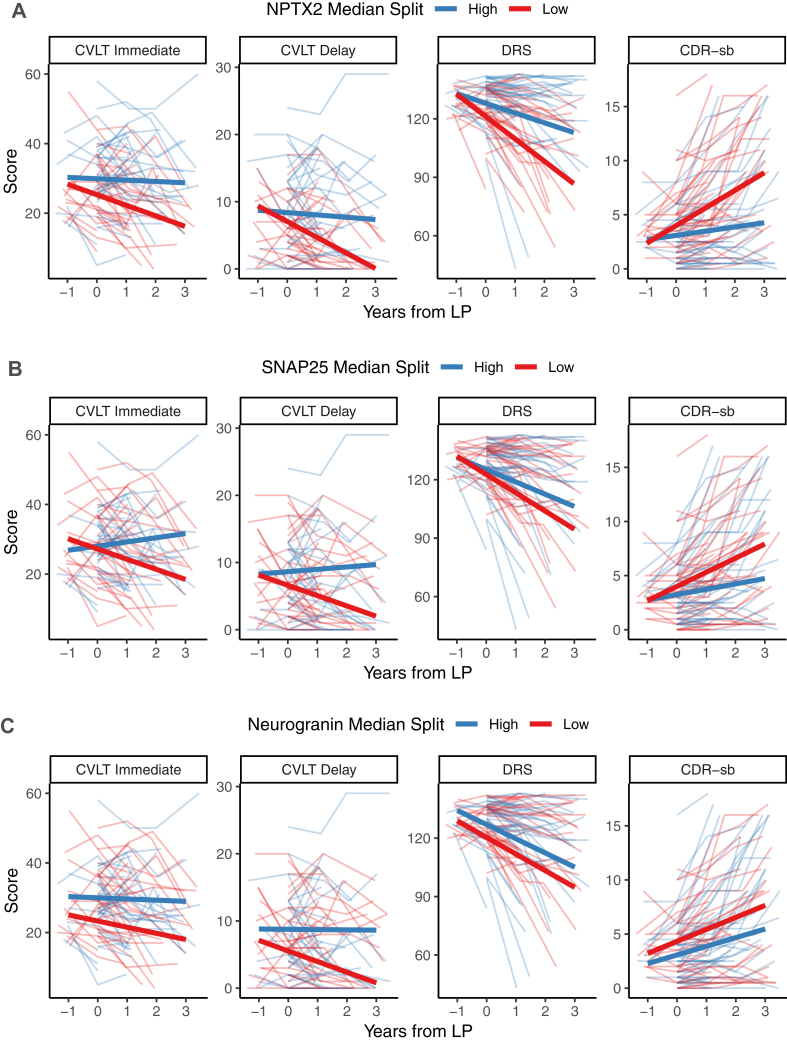
Biomarker prediction of longitudinal progression. Progression on the CVLT (immediate and delay), MDRS, and CDR Sum of Boxes (CDR-sb) divided via a median split of each CSF biomarker, NPTX2 (A), SNAP25 (B), and neurogranin (C), in subjects with diagnoses of MCI or AD. Raw data of individual participants is shown in the background, overlaid with predictions from longitudinal mixed-effect models, adjusted for demographics, Aβ1-42, and Tau. Note that in the model, each biomarker was treated as a continuous variable, but was dichotomized by median split for these graphical purposes only. The models and effects of biomarkers and other predictors are fully presented in Table 2.